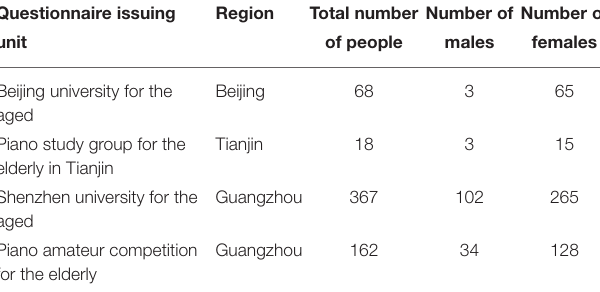
TABLE 2 | Questionnaire survey information table of